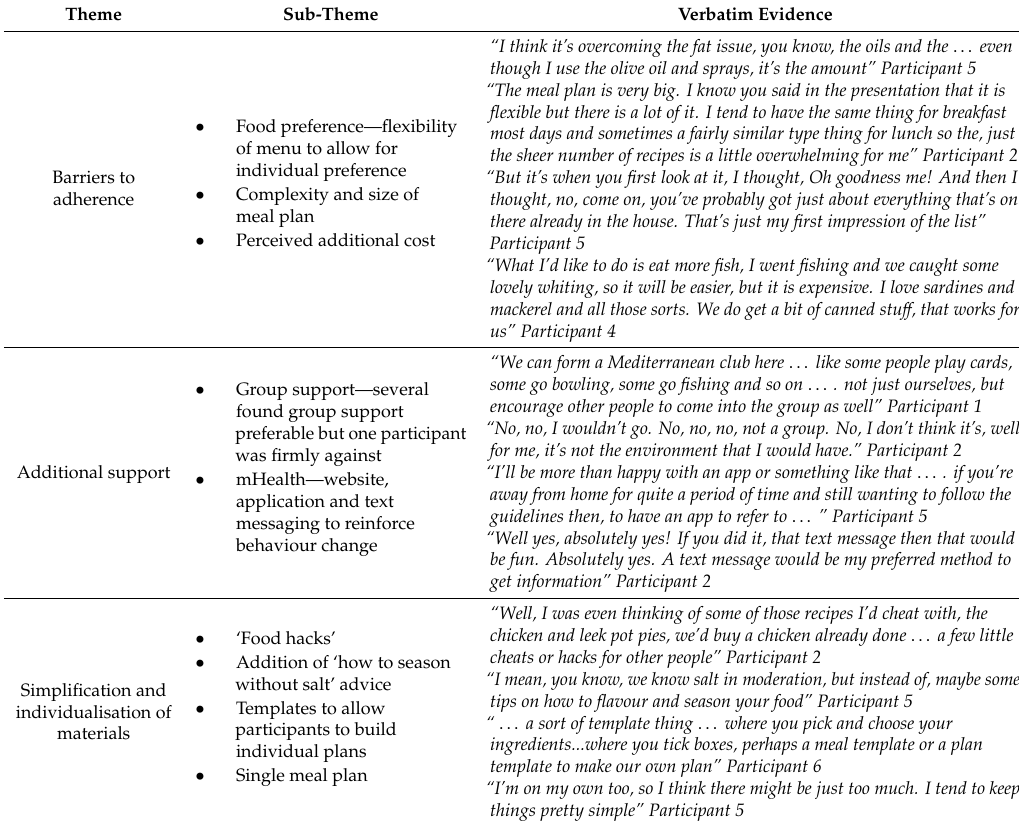
Table 2. Thematic analysis of semi-structured interviews ( n = 6) from Phase 1—the acceptability and feasibility of materials from the AusMed diet